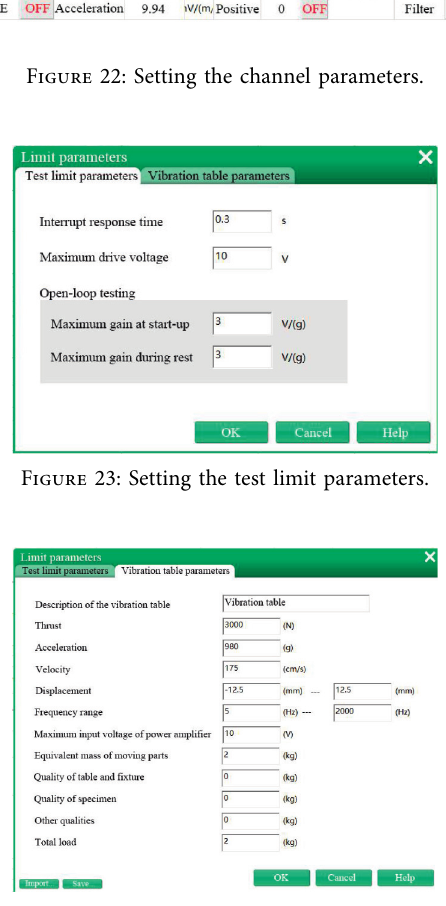
Figure 24: Setting the vibration table parameters.